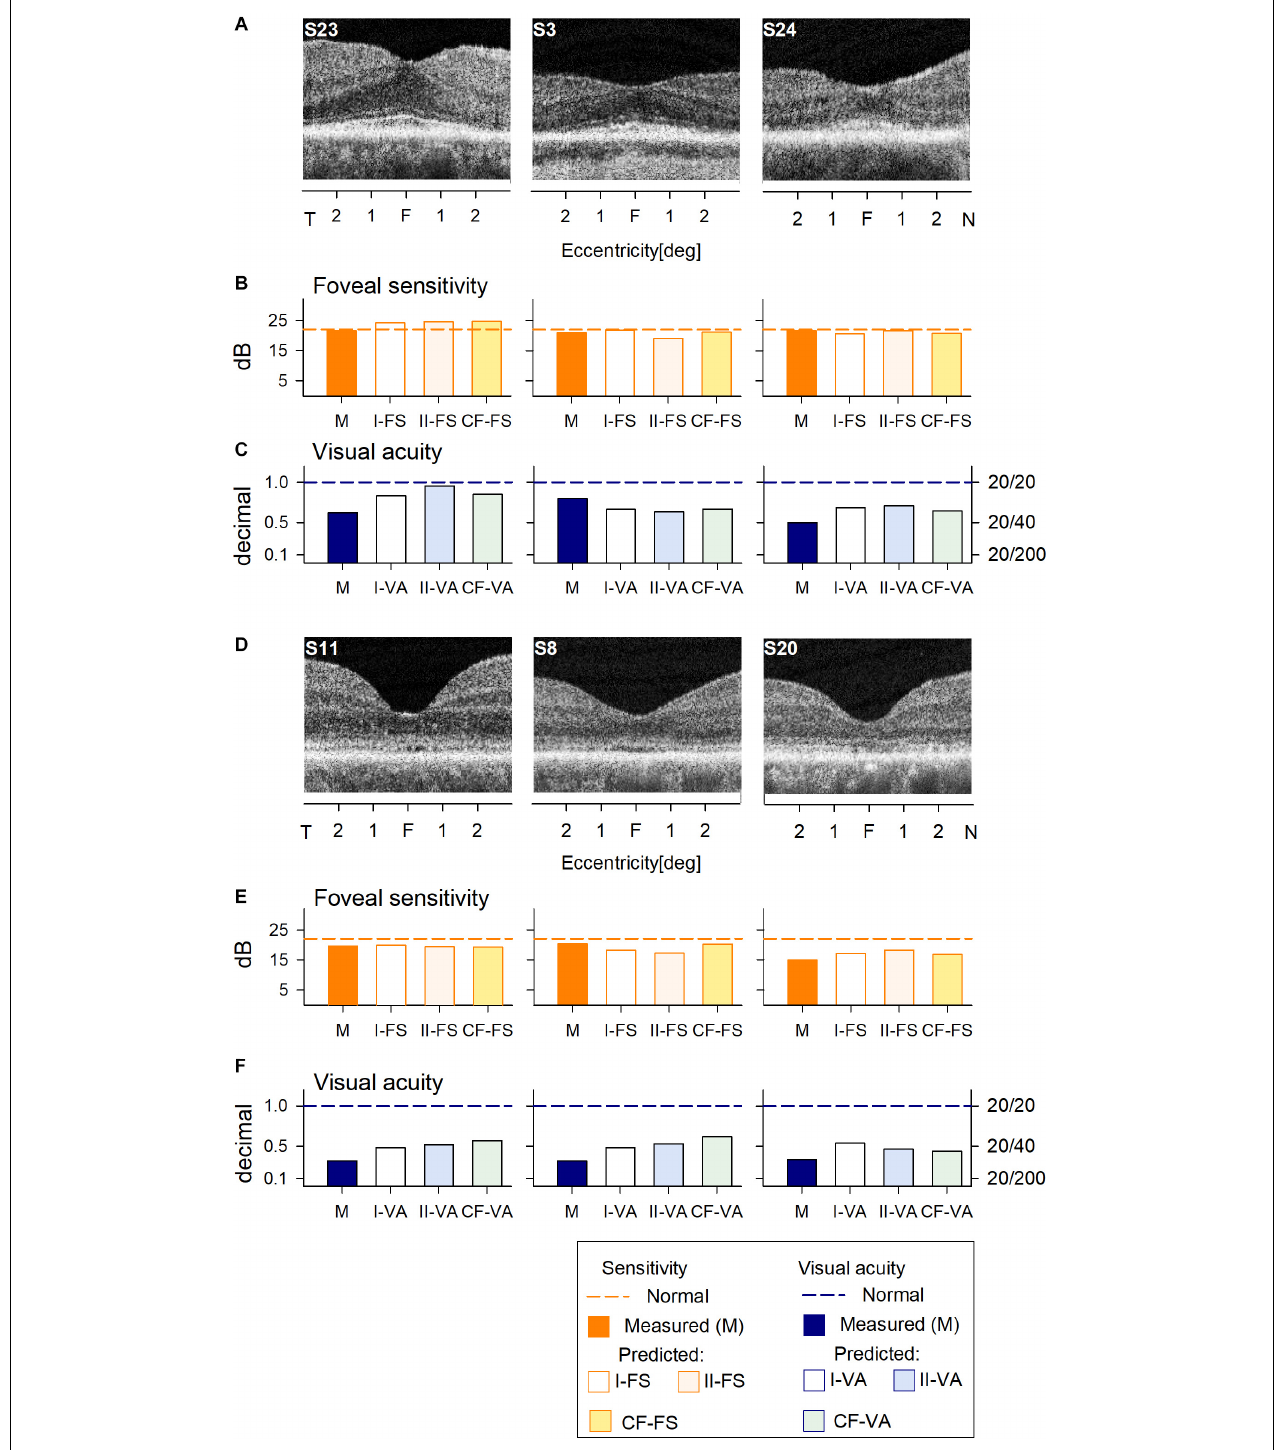
FIGURE 1 | Prediction of foveal sensitivity (FS) and visual acuity (VA) in the IRD training set group. (A) Foveal region OCT scans from 3 IRD subjects (S23, S3, S24) representing different ONL thicknesses. (B) Comparison of measured FS (M, orange bar) and predicted results by Model I-FS (white bar) and Model II-FS (light orange bar). Yellow bar is FS value calculated by formula extracted from curve fitting (CF-FS). (C) Comparison of measured VA (dark blue bar) and predicted by Model I-VA (white bar) and Model II-VA (light blue bar). Light green bar is VA calculated by a formula extracted from curve fitting (CF-VA). (D–F) are the same as (A–C) but the scans are from 3 IRD subjects (S11, S8, S20) who have visible defects of IS/OS similar to those encountered in some BCM patients. Dashed lines in (B,C,E,F) represent lower boundary of normal range.